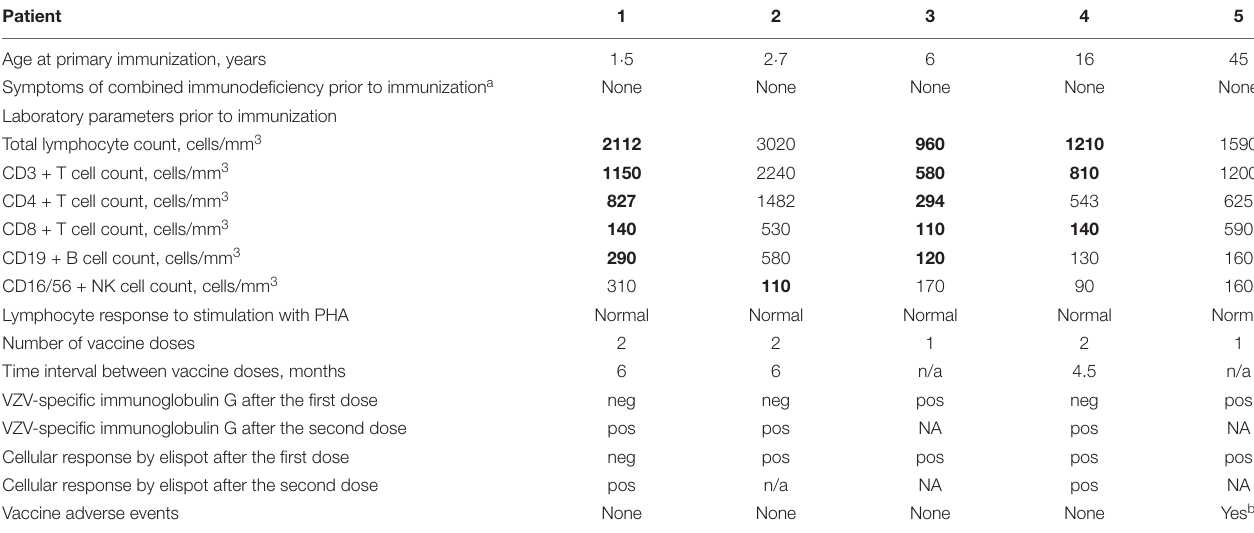
Numbers in bold represent cell counts below the normal range for age. n/a not available, NA – not applicable, neg – negative, PHA – phytohemagglutinin, pos – positive, VZV – varicella zoster virus. a Including severe or opportunistic infections, autoimmunity, or malignancy. b Post-immunization adverse events (rash and knee swelling) are described in detail in